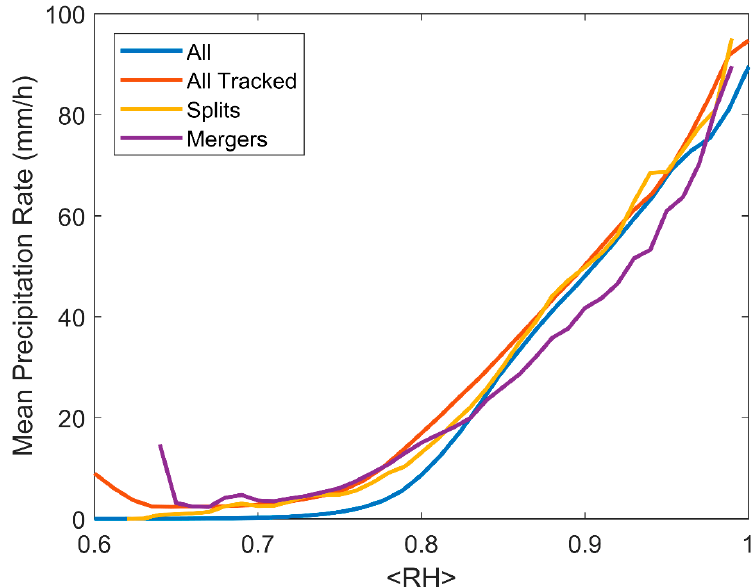
Figure 1. The P (<RH>) relationship for all shadow points for all clouds over the tracking period (the final 3 days of the simulation) (‘Tracked Clouds’; red), the subset of those pixels occurring just before a split (gold), and just before a merger (purple), and the control P (<RH>) (‘All Points’) from the hourly output of the final 11 days of the simulation (blue).